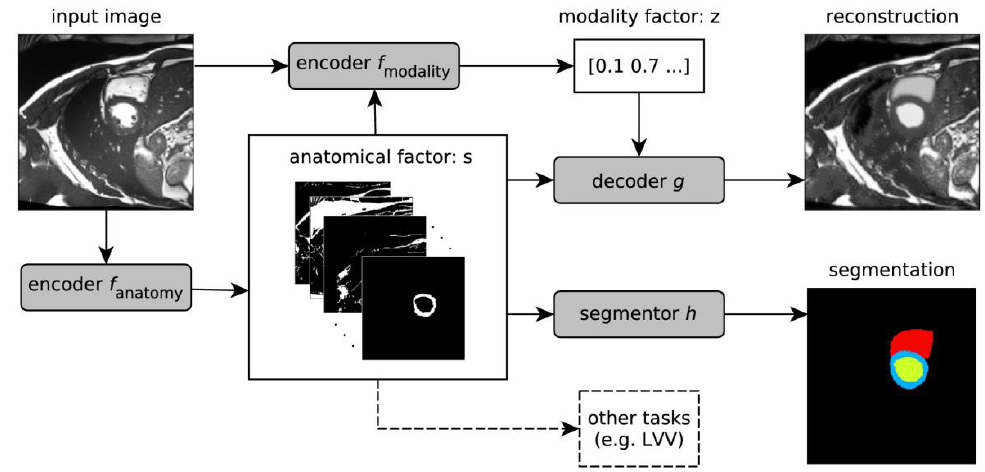
Figure 8. Schematic overview of the proposed model. An input image is first encoded as a multi-channel spatial representation and an anatomical factor s is extracted using an anatomy encoder f anatomy . Then s can be used as an input to a segmentation network h to produce a multi-class segmentation mask (or some other task specific network). The anatomical factor s when integrated with the input image through a modality encoder f modality is used to produce a latent vector z representing a specific imaging modality. The two representations s and z are then combined through a decoder to reconstruct the input image through the decoder network g for image reconstruction or a segmentor h for segmentation. This overview was developed in line with [105]. LVV means the Left Ventricular Volume.